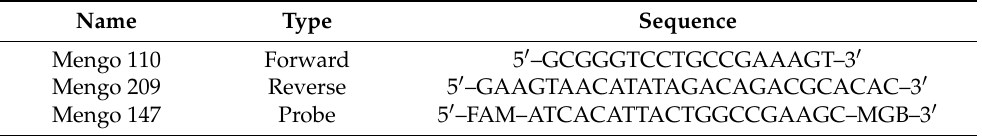
Table 2. Primers and probe used to detect Mengovirus in Real-time PCR.